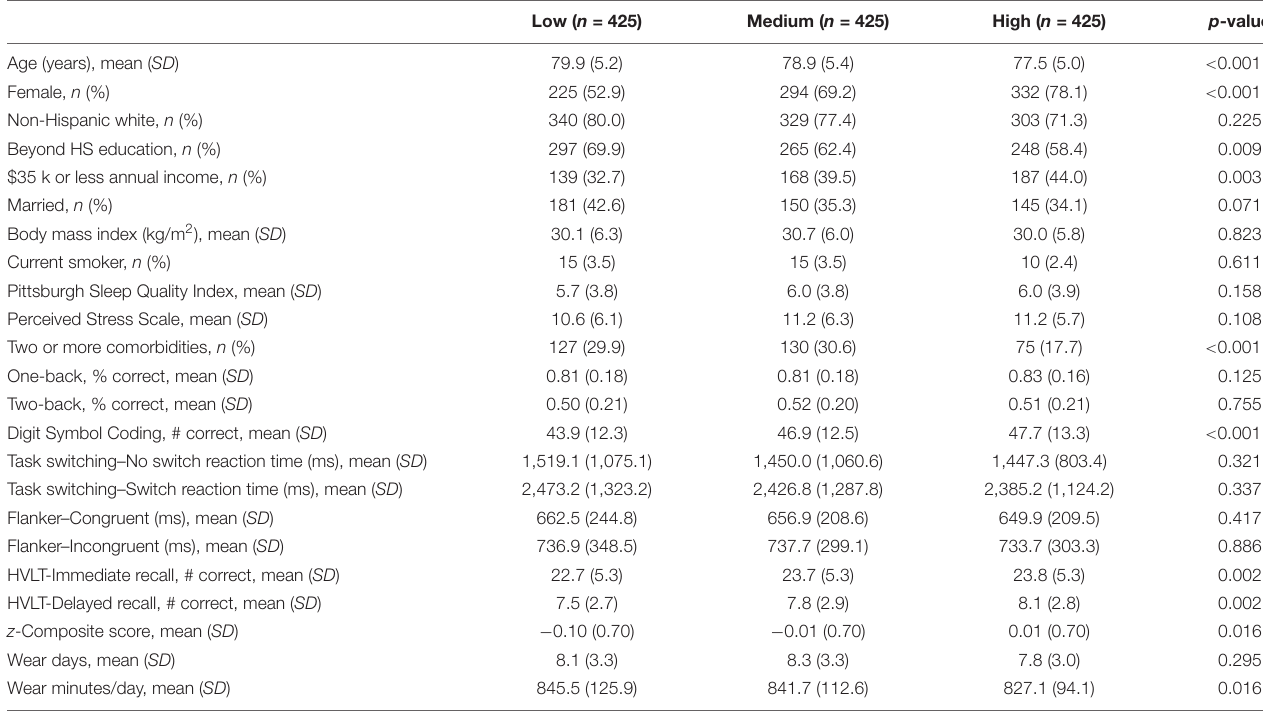
TABLE 1 | Participant characteristics stratified by physical activity (PA)-based tertiles, n =